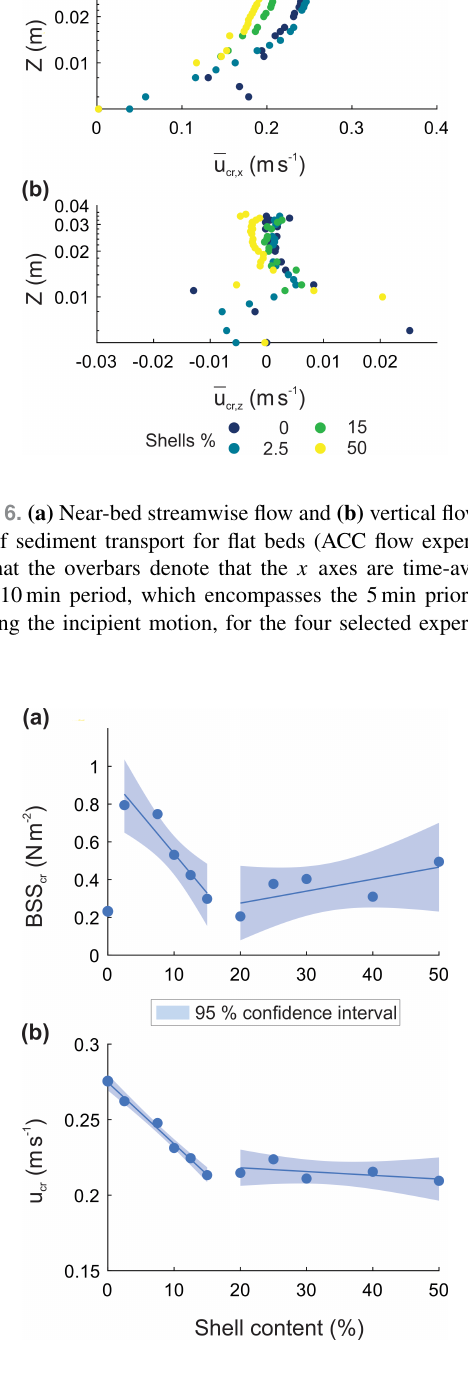
Figure 7. (a) The critical BSS for incipient motion and the (b) cor- responding depth-averaged velocity for the ACC flow experiment. The shaded regions represent the 95th percentile confidence inter-